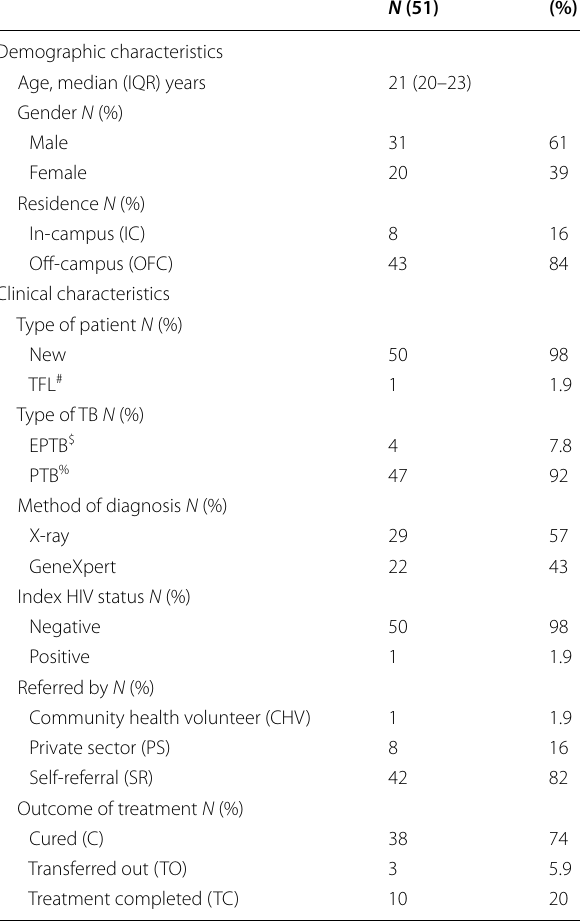
Table 1 Demographic and clinical characteristics of TB index